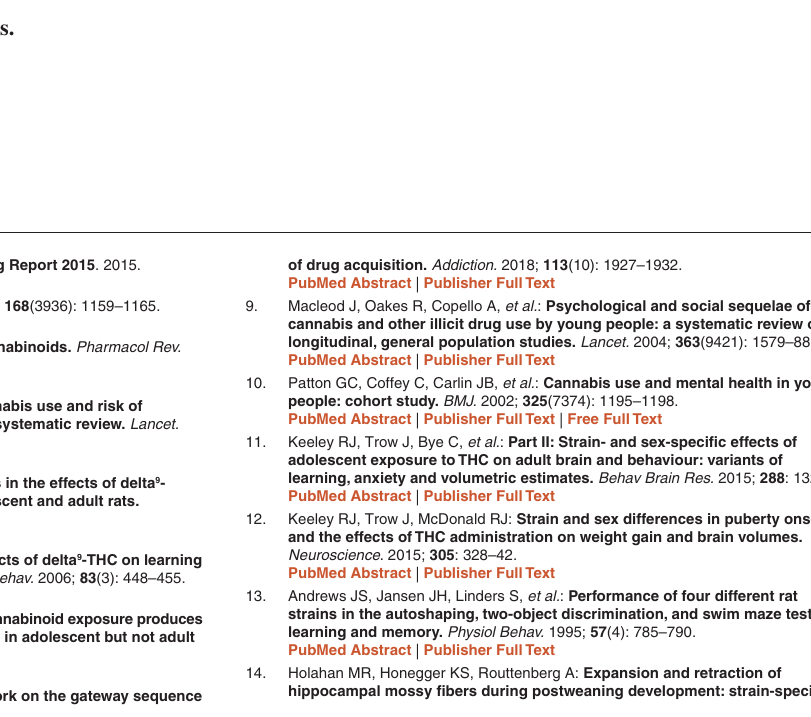
Dataset 1: Raw data associated with Figure 1–Figure 4. 10.5256/ f1000research.14029.d196720